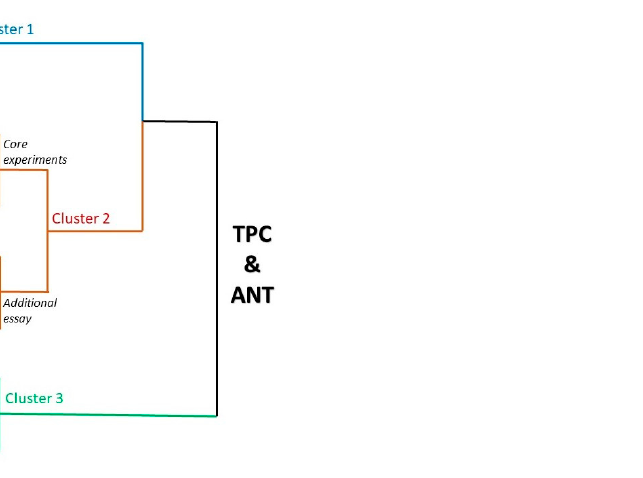
Figure 5. Dendogram for hierarchical clustering obtained for total phenolic compounds and antocyanins.